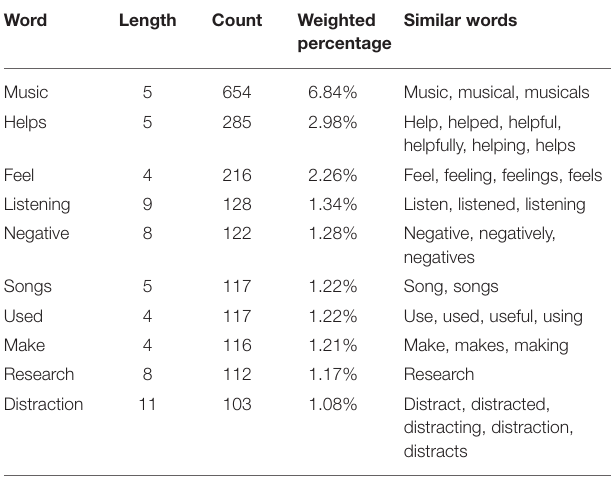
TABLE 1 | Top 10 most frequently used words in free-text